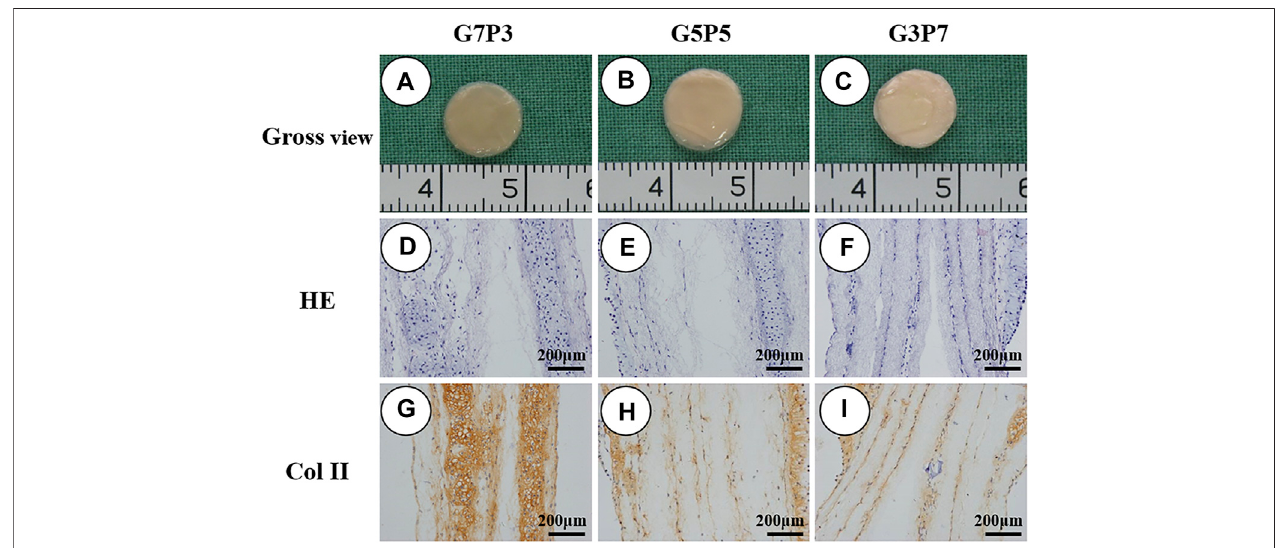
FIGURE2| Grossviewandhistologicalexaminationofengineeredtissuesat2 weeks invitro .Allthesamplesbasicallymaintainthecylindershapeaftercellseeding andretaintheoriginalshapeafter invitro implantation (A – C) .Thesamplesinallgroupsformcartilage-liketissuewithtypicallacunastructureandpositivestainingoftypeII collagen (D – I) . In the G7P3 group (G) , the samples show obviously positive staining of type II collagen than the other two groups (H,I) .